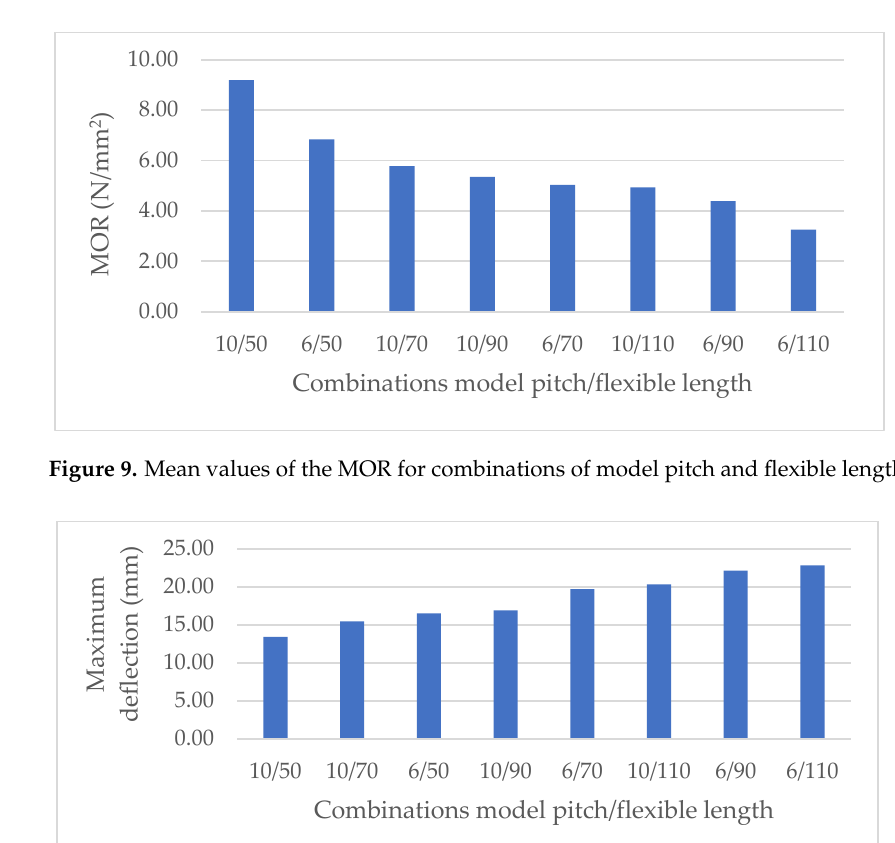
Figure 8. Mean values of the MOE for combinations of model pitch and flexible length.